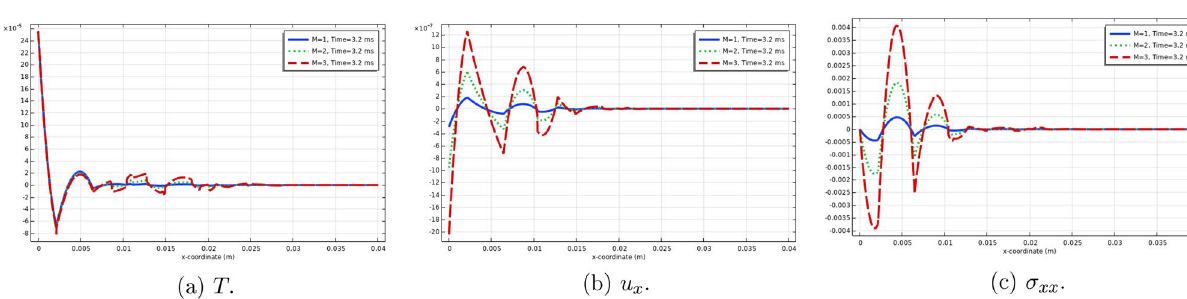
Figure 12. Distributions of T , u x and σ xx on the median line y